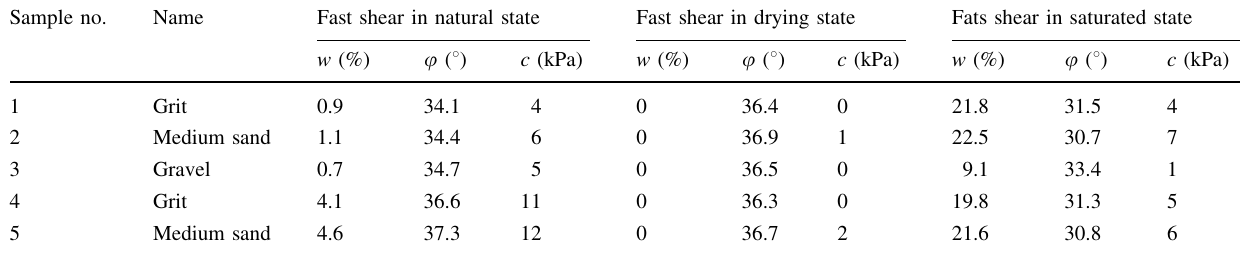
Table 1 Shear strength parameters in a sand debris flow Sample no.